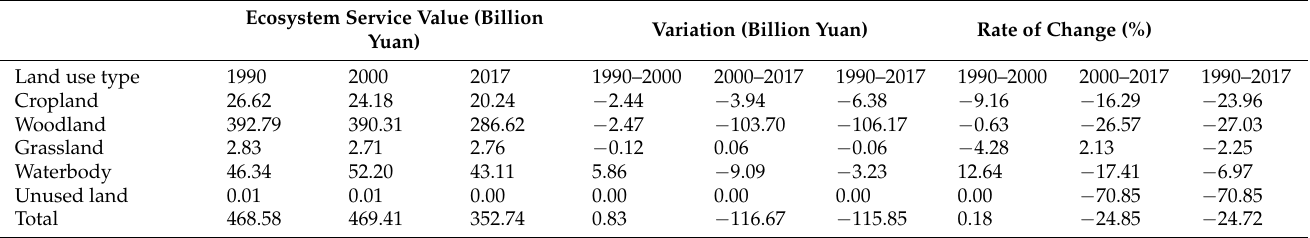
Table 5. ESVs in the PRD region from 1990 to